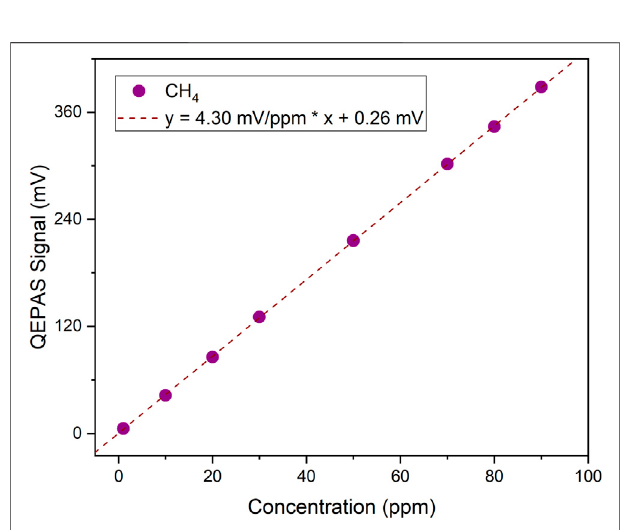
FIGURE 6 | Absorption cross-section of modi fi ed standard air (United States model, mean latitude, summer enriched with 500 ppb of NO) withintheS2lasersourceemission range,simulatedusingHITRANdatabase. The inset highlights the spectral region between 1899.85 cm − 1 and 1900.75 cm − 1 . Cyan and red arrows indicate water vapor and nitric oxide absorption features,